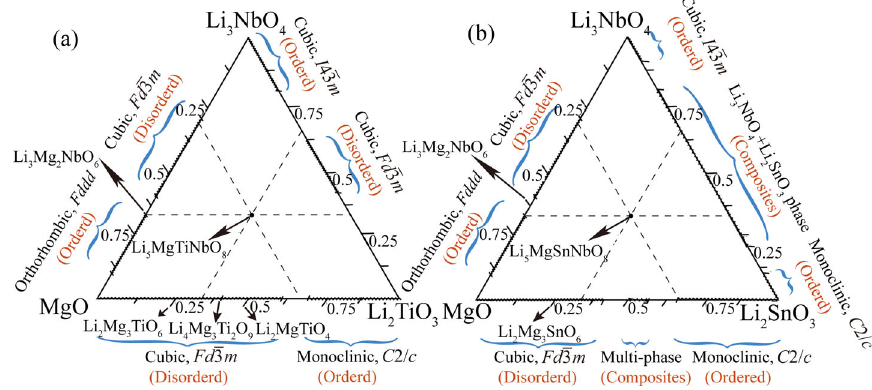
Fig. 11 Pseudo phase diagrams of (a) Li 2 TiO 3 –Li 3 NbO 4 –MgO and (b) Li 2 SnO 3 –Li 3 NbO 4 –MgO ternary systems. Reproduced with permission from Ref. [246], © Elsevier Ltd and Techna Group S.r.l. 2020.